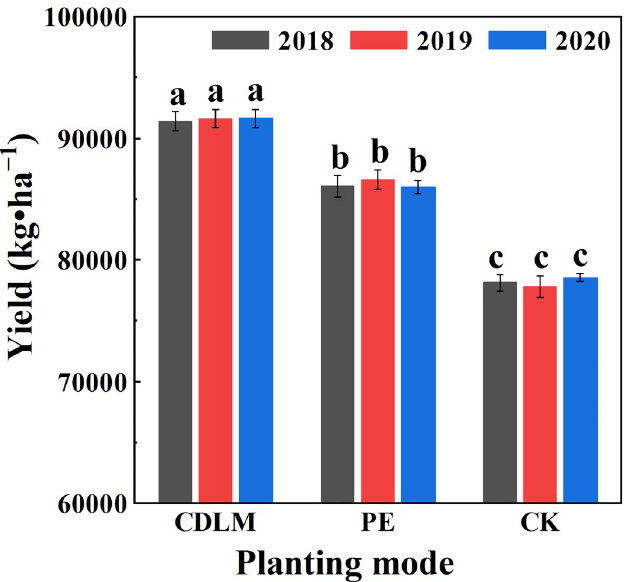
Fig 8. The silage corn yields under CDLM, PE films and CK in 2018, 2019 and 2020. Different superscripted letters (a, b, and c) indicate significant differences between the treatments in each year (p < 0.05).